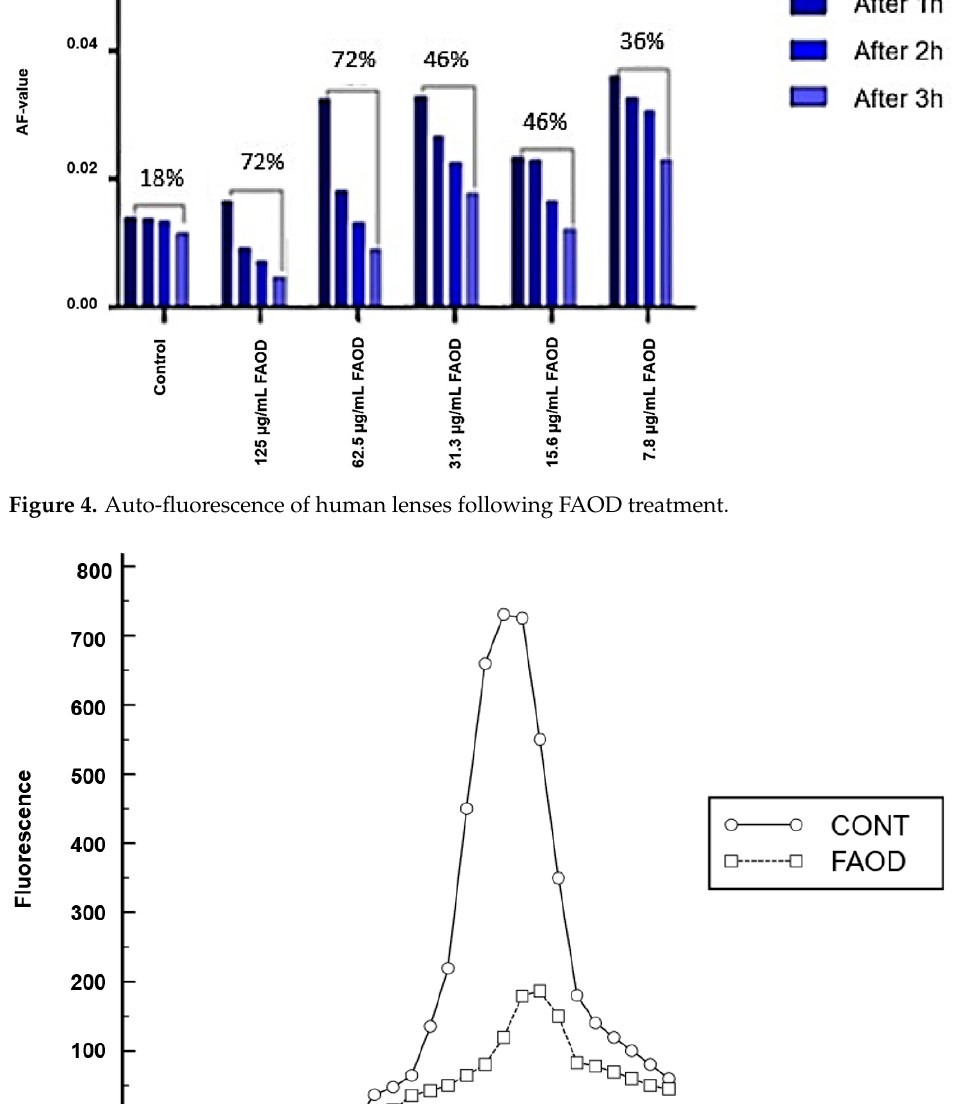
Figure 5. Gel permeation chromatography. Fluorescence (488 nm) following treatment of human lens fragments with the deglycating enzyme FAOD (excitation wavelength 365 nm). fragments with the deglycating enzyme FAOD (excitation wavelength 365